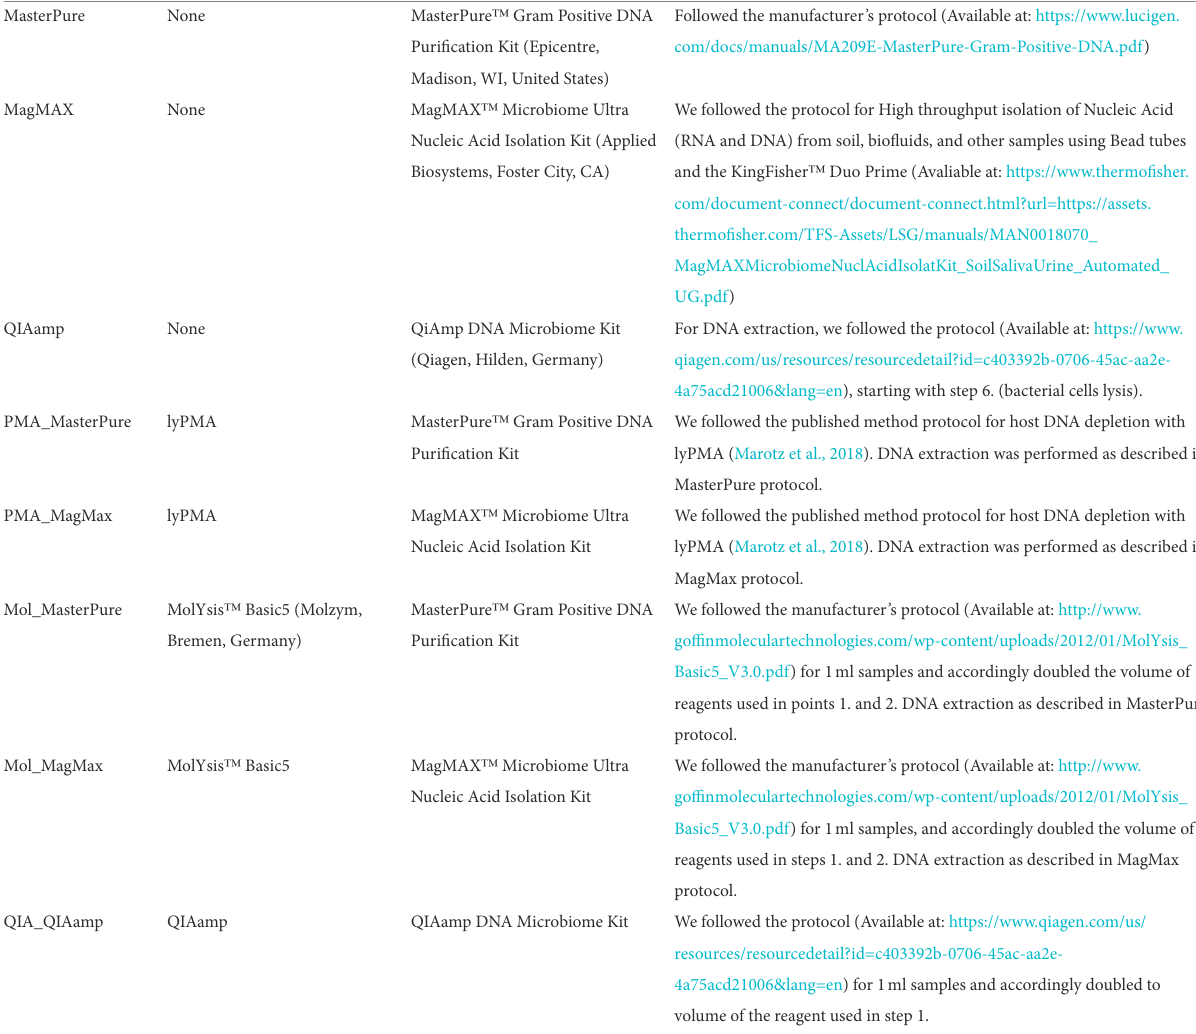
TABLE 1 Host DNA depletion and DNA extraction